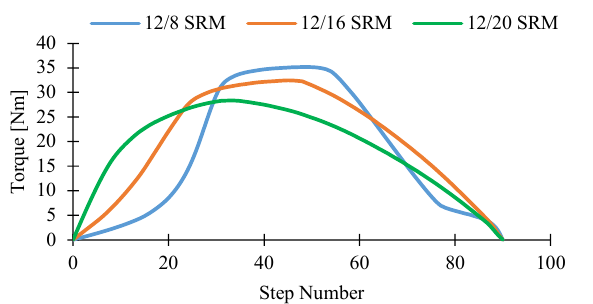
Figure 6. Static electromagnetic torque at a 60 A excitation current for 12/8, 12/16, and 12/20 SRMs. For the given speed range and the stator outer diameter, 16 rotor poles are a bet- ter choice to maintain an effective stator pole width considering torque density, and a reasonable electrical frequency considering core loss for the given speed